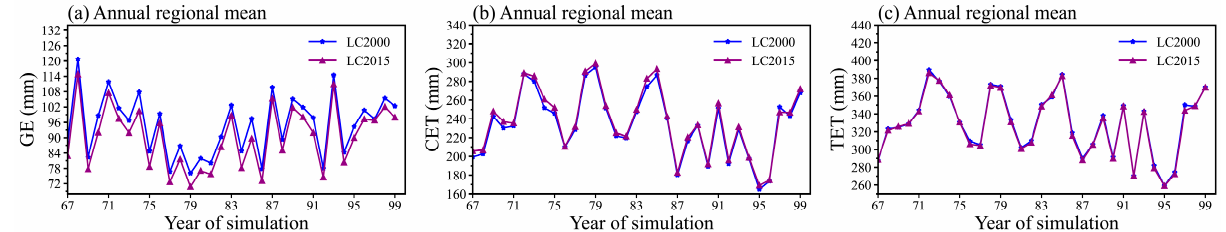
Figure 5. Area-averaged annual ( a ) ground evaporation, ( b ) canopy ET, and ( c ) total ET and their linear trends (unit: mm/year) for LC2000 and LC2015 on the LP.